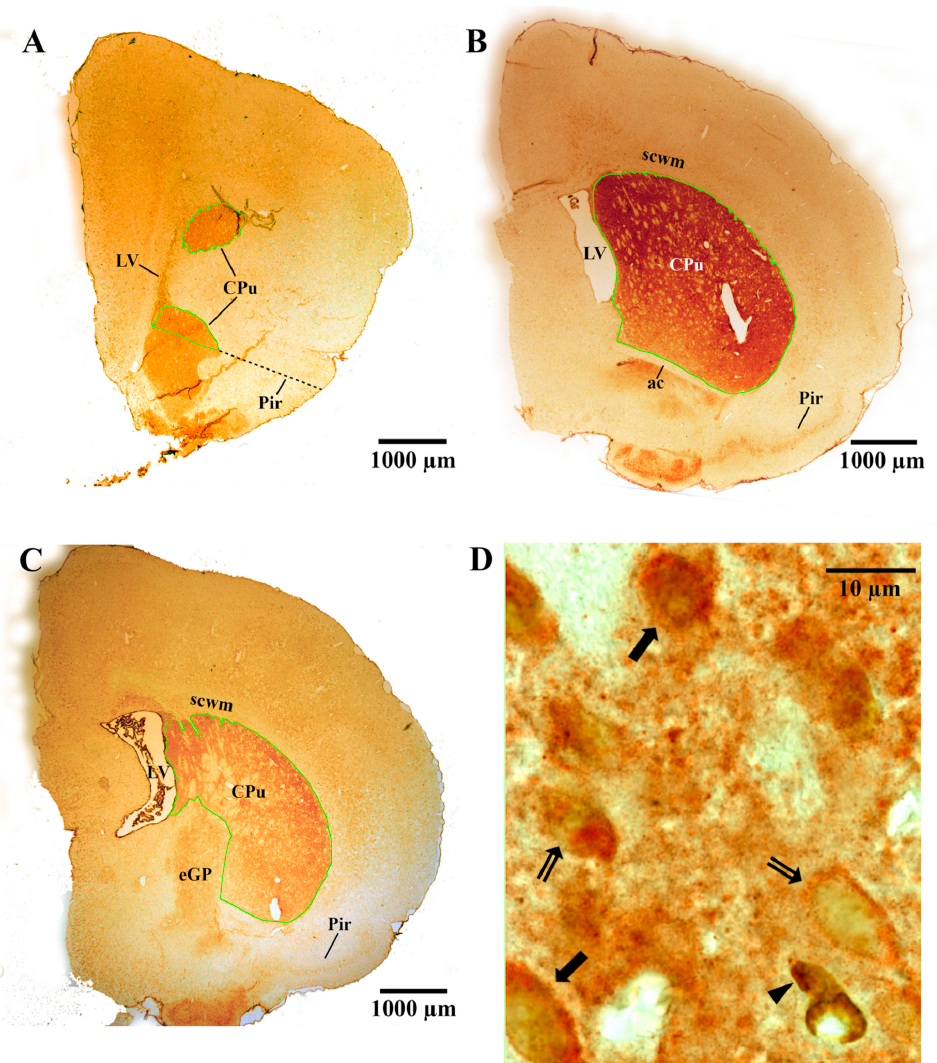
Figure 4. Representative images of the caudate-putamen (CPu), including immunostained medium-spiny neurons. ( A – C ) Light microscopic images of the CPu from a postnatal day (PN) 21 rat pup that was exposed to hypoxia-ischemia (HI) at PN7 and treated with adipose-derived-mesenchymal stem cells (AD-MSCs; A , B ) or diluent ( C ) on PN14 and PN16. The CPu is specifically delineated with a green contour to measure the reference volume, Vref. The dotted black line in ( A ) is used to determine the inferior boundary (see also the text in the Methods). ( D ) Light microscopic image of medium-spiny neurons (i.e., dopamine and cyclic AMP-regulated phosphoprotein (DARPP-32)-positive neurons) in the CPu of a HI diluent-treated PN21 rat. The DARPP-32-positive neurons appeared as orange-colored cells (i.e., they had DARPP-32-positive orange staining in their cytoplasm from immunostaining with 3-amino-9-ethylcarbazole). Some of the neurons had large visible unstained nuclei (indicated by the double-tailed arrows). DARPP-32-positive/bromodeoyxyuridine (BrdU)-positive medium-spiny neurons had brown-stained nuclei due to BrdU immunostaining with diaminobenzidine (indicated by the solid black arrows). Note that the cell indicated at the black arrowhead is labeled with BrdU only. ac, anterior commissure; eGP, external globus pallidus; LV, lateral ventricle; Pir, piriform cortex; scwm, subcortical white matter.